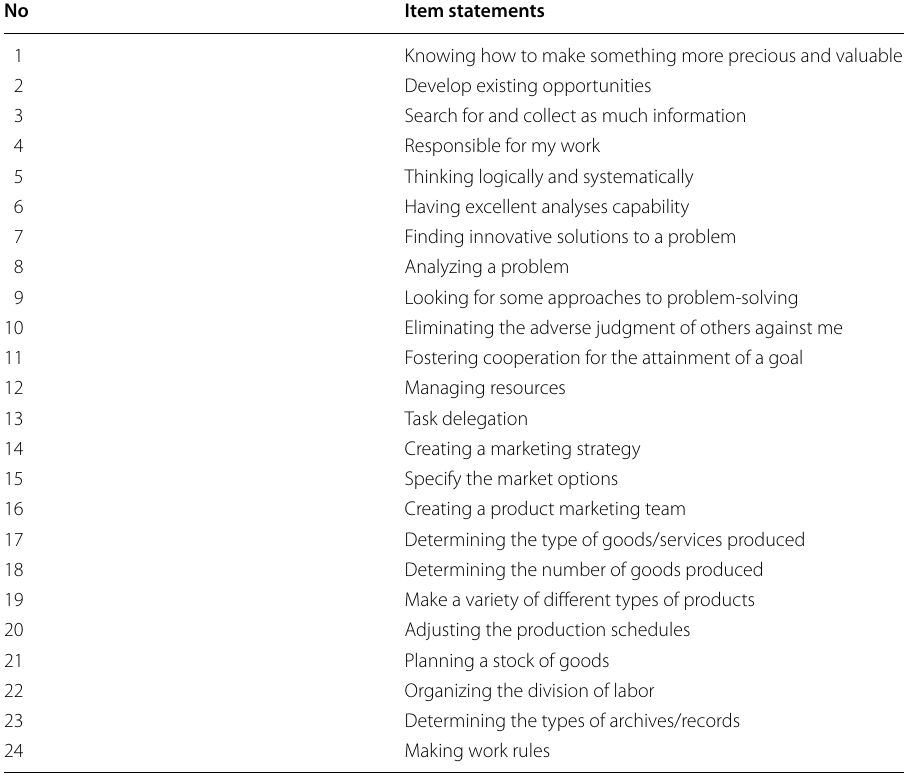
Table 1 Items of self-assessment perceived entrepreneurial competencies (Riyanti & Suwartono,